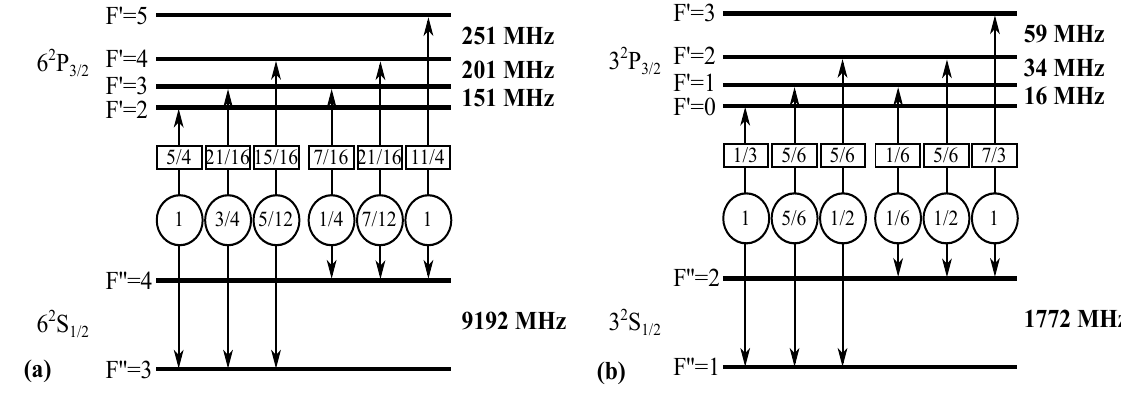
Figure 1. Transition strength ˜ S F ” F (cid:48) (boxed) and branching Π (circled) factors for the hyperfine components of D 2-lines for ( a ) cesium (transition 6 2 s 1/2 → 6 2 p 3/2 ) and ( b ) sodium (transition 3 2 s 1/2 → 3 2 p 3/2 ) atoms. For cyclic (closed) transitions, the factor Π = 1. The natural lifetime τ (cid:112) and saturation threshold Ω st = 1/ ( τ 2 ) of the resonance states are τ = 30.5 ns and Ω st = 3.7 MHz for Cs while τ = 16.4 ns and Ω st = 6.9 MHz for Na,